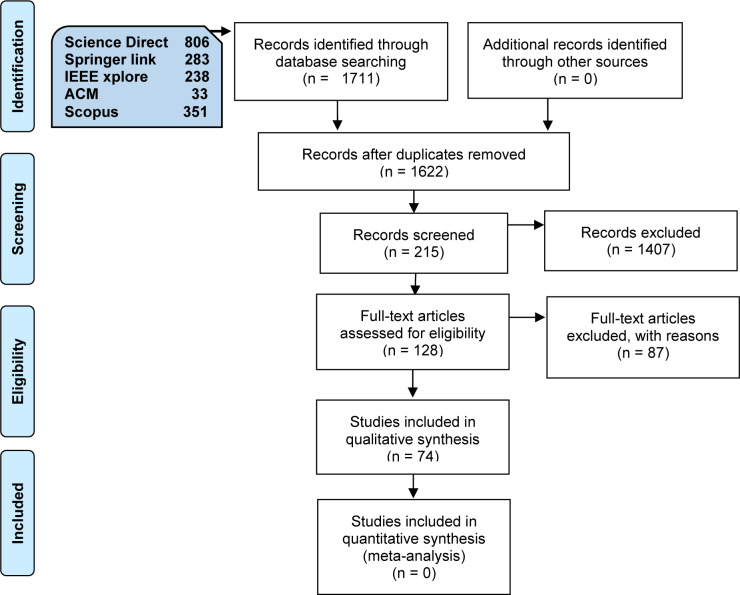
PRISMA flow diagram.